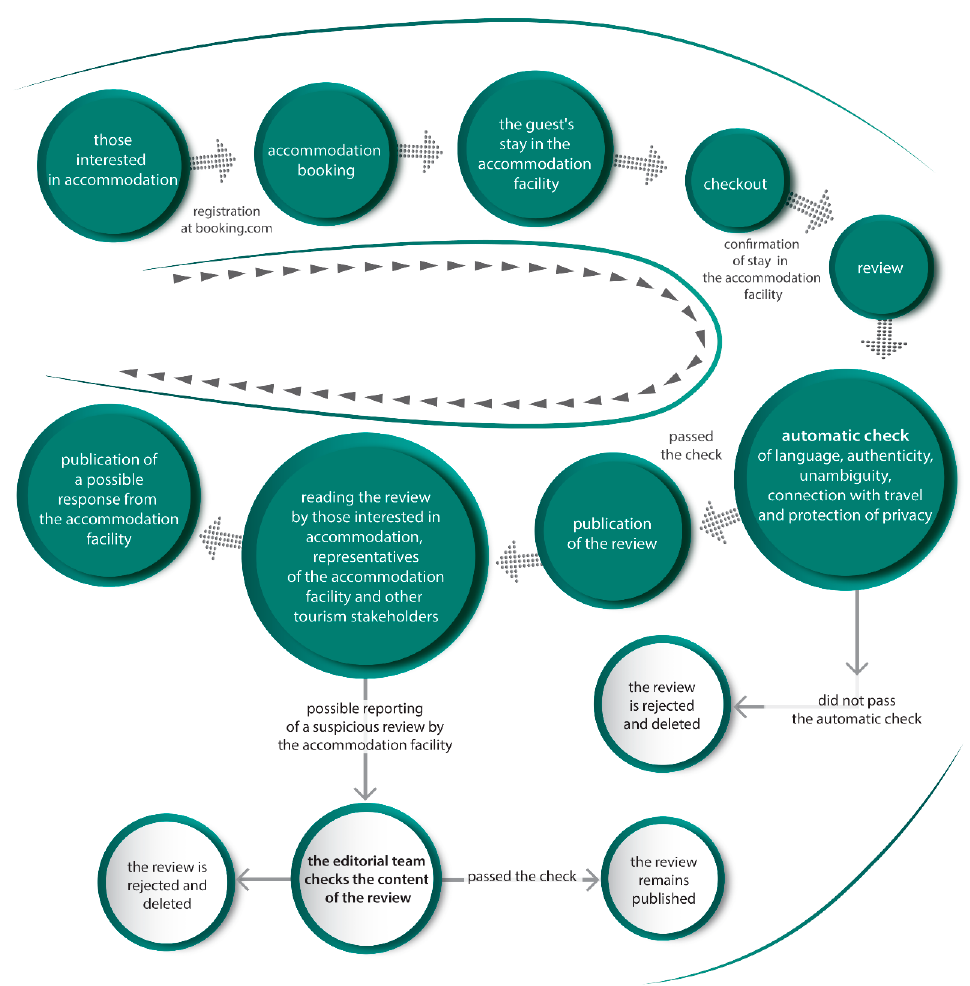
Figure 3. Booking.com review process. Source: Booking.com (2020a, 2020b). Table 1. A SWOT analysis of review verification processes of TripAdvisor and Booking.com re-